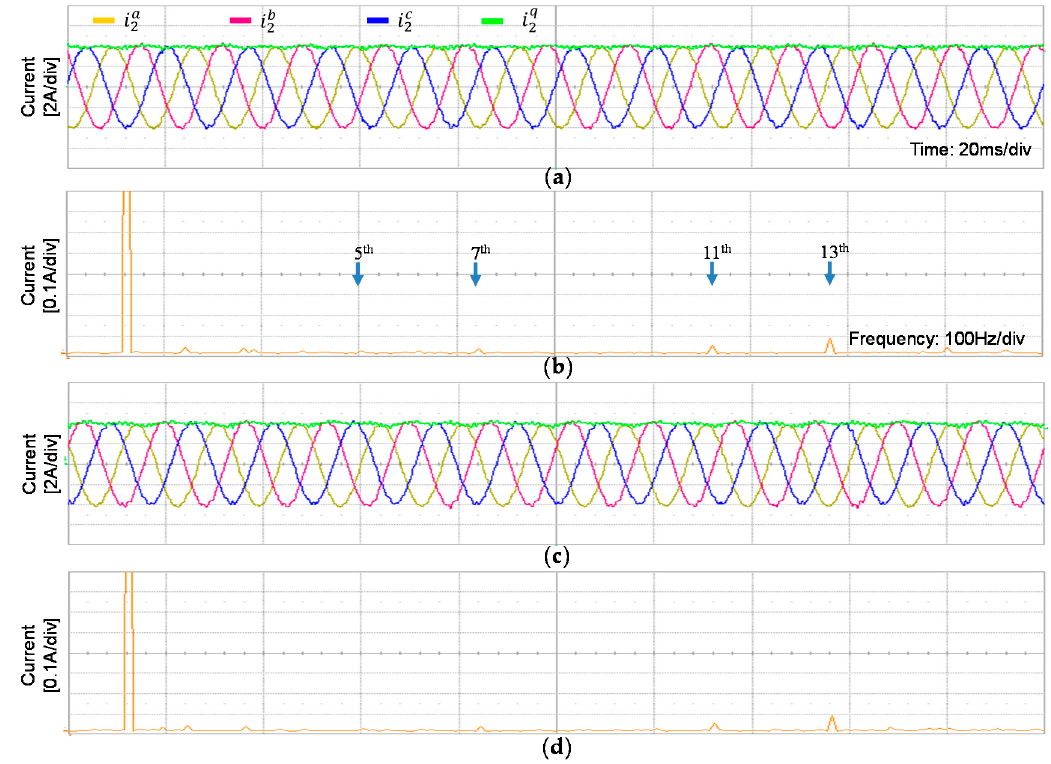
Figure 21. Experimental results of the proposed controller under the LCL filter parameter variations under distorted and imbalanced grid voltages with e a drop to 83.33% of the nominal value. ( a ) Three-phase grid currents: the filter capacitance C f creases from 4.5 µ F to 3 µ F; ( b ) FFT result of phase- a current: the filter capacitance C f decreases from 4.5 µ F to 3 µ F; ( c ) Three-phase grid currents: the filter capacitance C f increases from 4.5 µ F to 6 µ F; and ( d ) FFT result of phase- a current: the filter capacitance C f increases from 4.5 μ F to 6 μ F.